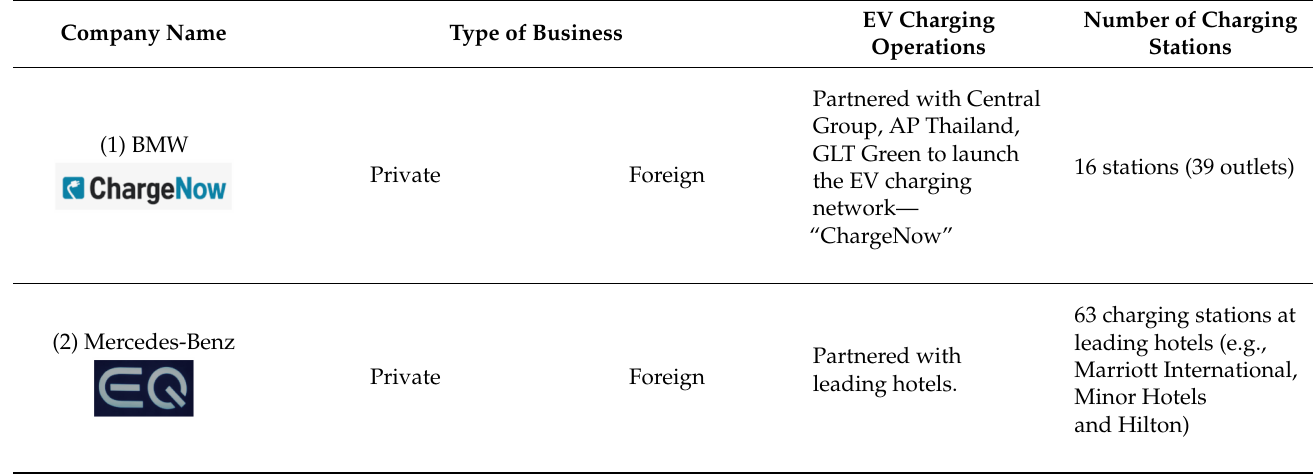
Table 8. EV charging operations of automotive